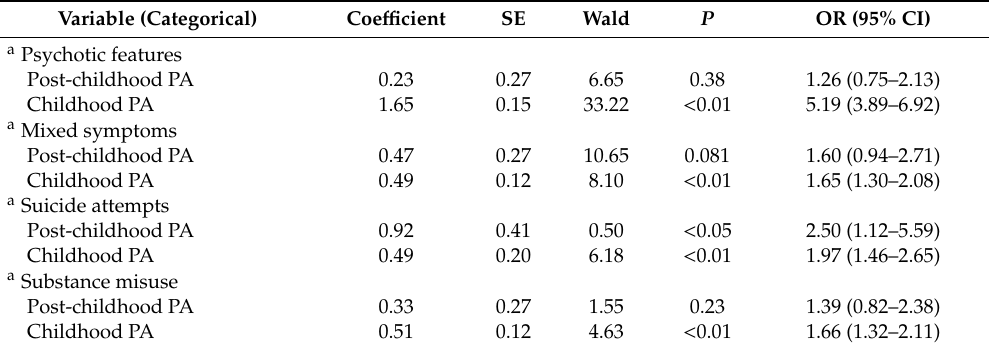
Table 7. Individual odds ratios for the presence of childhood physical abuse or post-childhood physical abuse and clinical outcomes of BD compared to the group without physical abuse